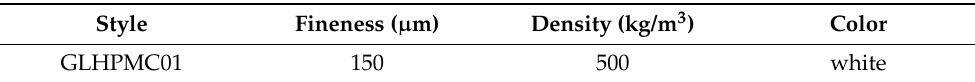
Table 4. Properties of the